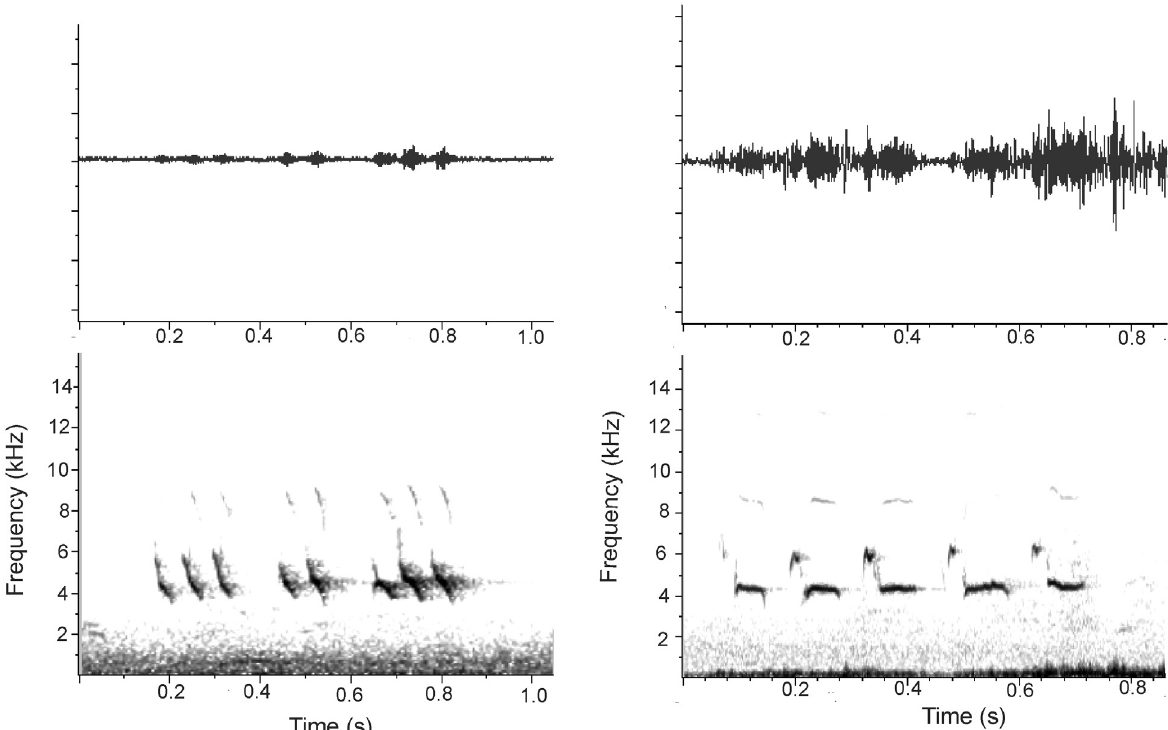
Figure 3. Oscillogram (upper part) and spectrogram (lower part) of unassigned call of P.